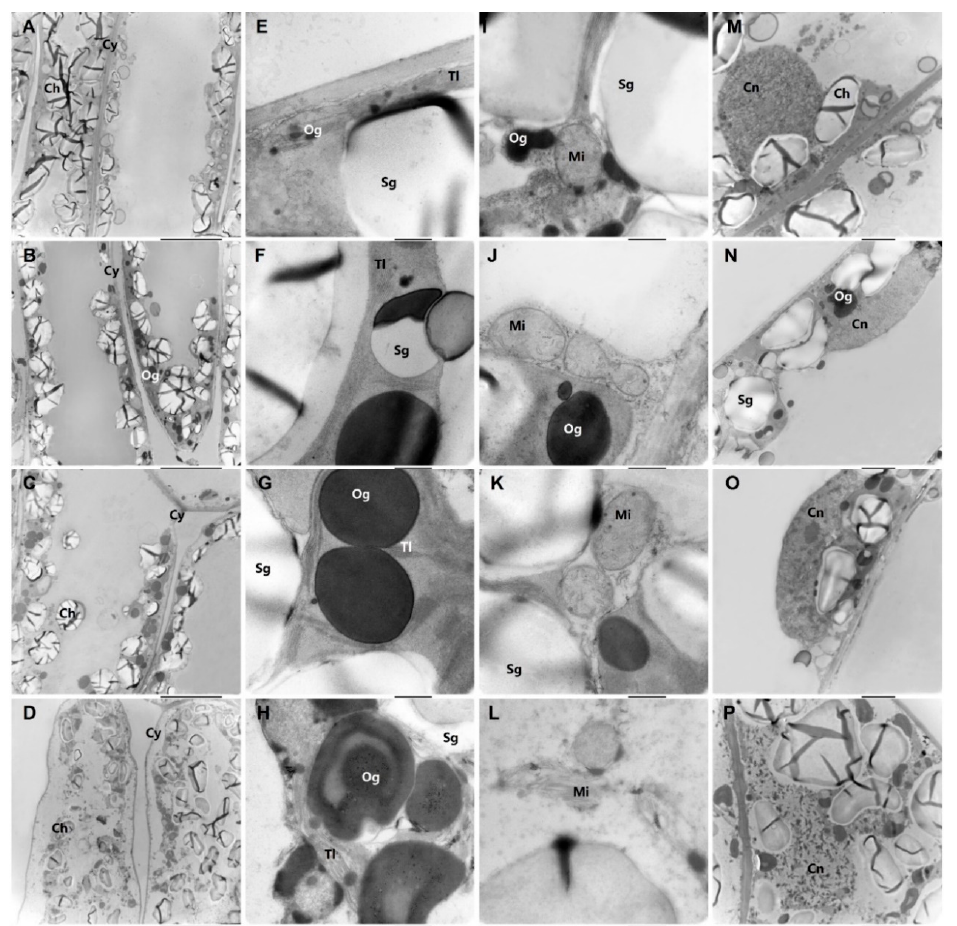
Figure 2. Ultrastructure of mesophyll cell at four stages. ( A , E , I , M ) Leaves of mature stage ( M ). ( B , F , J , N ) Leaves of early premature senescence stage (EA). ( C , G , K , O ) Leaves of middle premature senescence stage (MA). ( D , H , L , P ) Leaves of late premature senescence stage (LA). A – D , scale bars in bottom right corner of every picture correspond to 10 μ m; E – L , scale bars correspond to 500 nm; L – P , scale bars correspond to 2 μ m. Sg, starch grain; Tl, thylakoid lamellae; Og, Osmiophilic granules; Ch, Chloroplast; Cn, Cell Nucleus; Mi, Mitochondria; Cy, cytoderm.